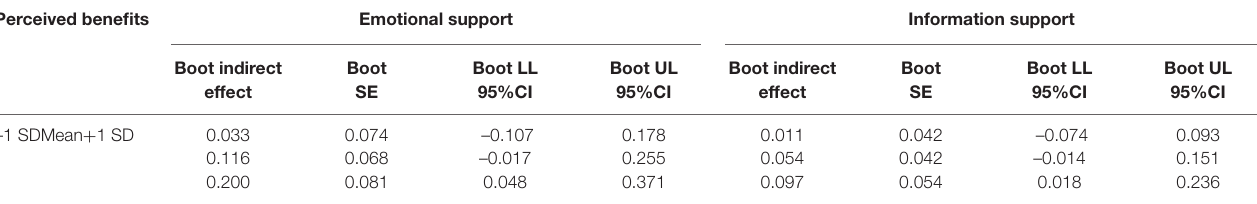
TABLE 7 | Moderated mediation model